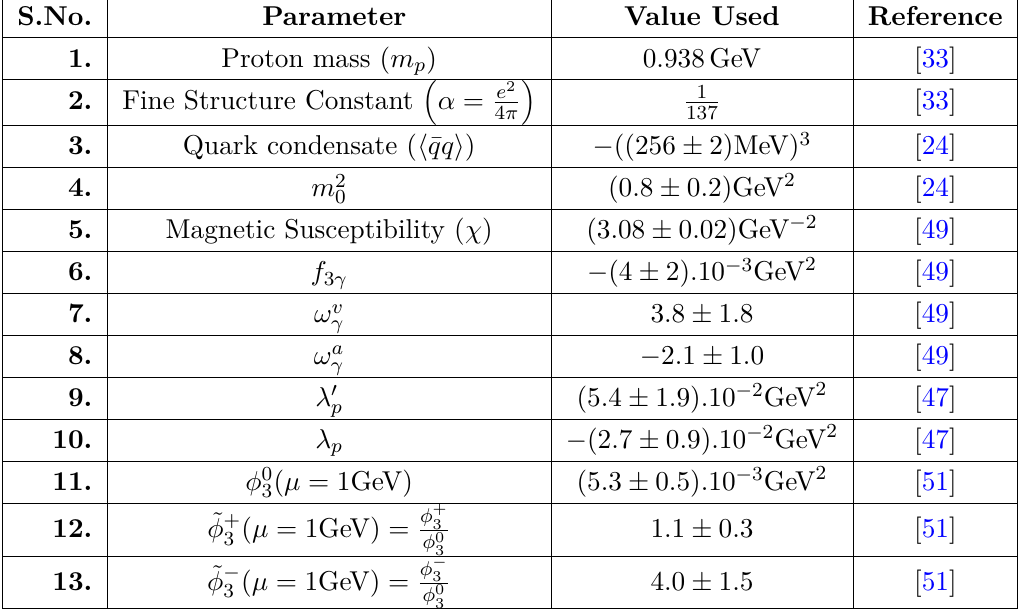
Table 1 . Numerical Values for the parameters used for numerical